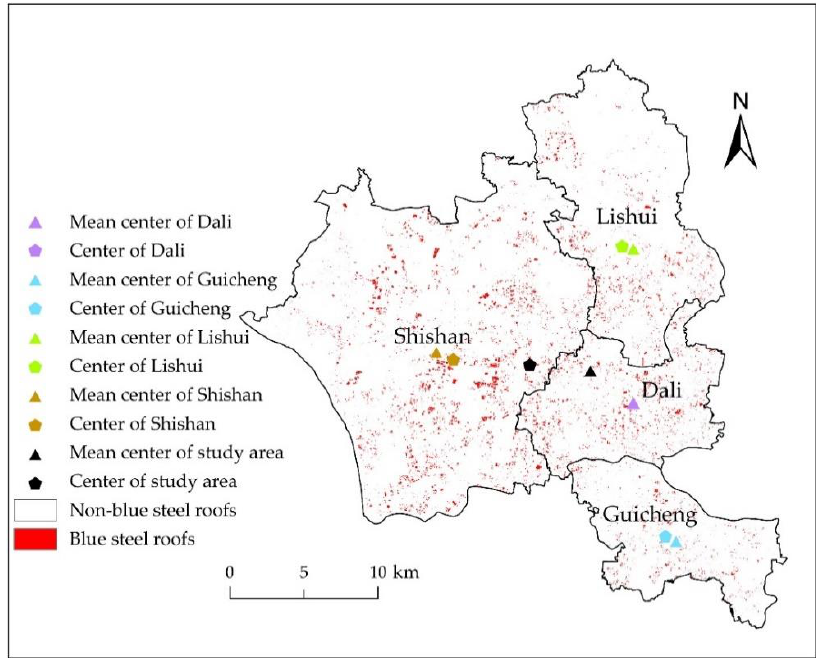
Figure 7. Spatial distribution center and mean center of blue steel roofs.